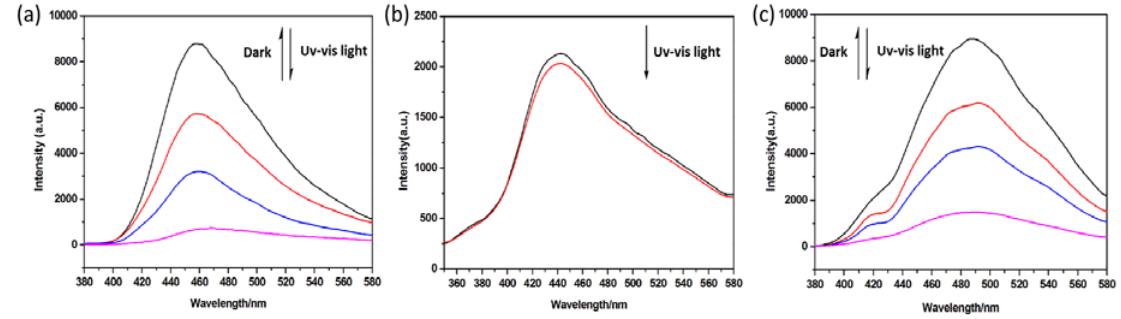
Figure 6. The photocontrolled tunable luminescence performance of 1 ( a ), 2 ( b ), and 3 ( c ), the spectra of 1 and 3 are measured every 2 min upon irradiations (300 W xenon lamp). The spectra of 1 and 2 were recorded upon irradiations (300 W xenon lamp) at every 2 minutes, the spectra of 2 were recorded before radiation (black line) and after radiation for 30 min (red line).